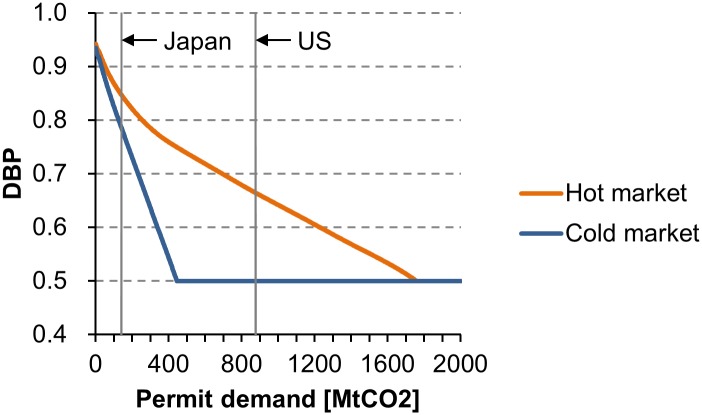
Curves of the demand-side bargaining power (DBP) in hot and cold markets.The DBP is obtained by putting the number of sellers (s), supply data (C
1, C
2,…, C
s), and demand data (∣C
−1∣) in Eq (12). Both markets contain 18 sellers (s = 18; Belgium, Bulgaria, Croatia, Czech Republic, Denmark, Estonia, Germany, Hungary, Latvia, Lithuania, Monaco, Poland, Romania, Russian Federation, Slovakia, Sweden, Ukraine, and the UK). The hot market is the real market shown by Fig 1. In the cold market, the supply from Russia and Ukraine is assumed to be zero. Each curve consists of 2,000 points of the DBPs corresponding to ∣C
−1∣ = 1,2,…,2000 (MtCO2).